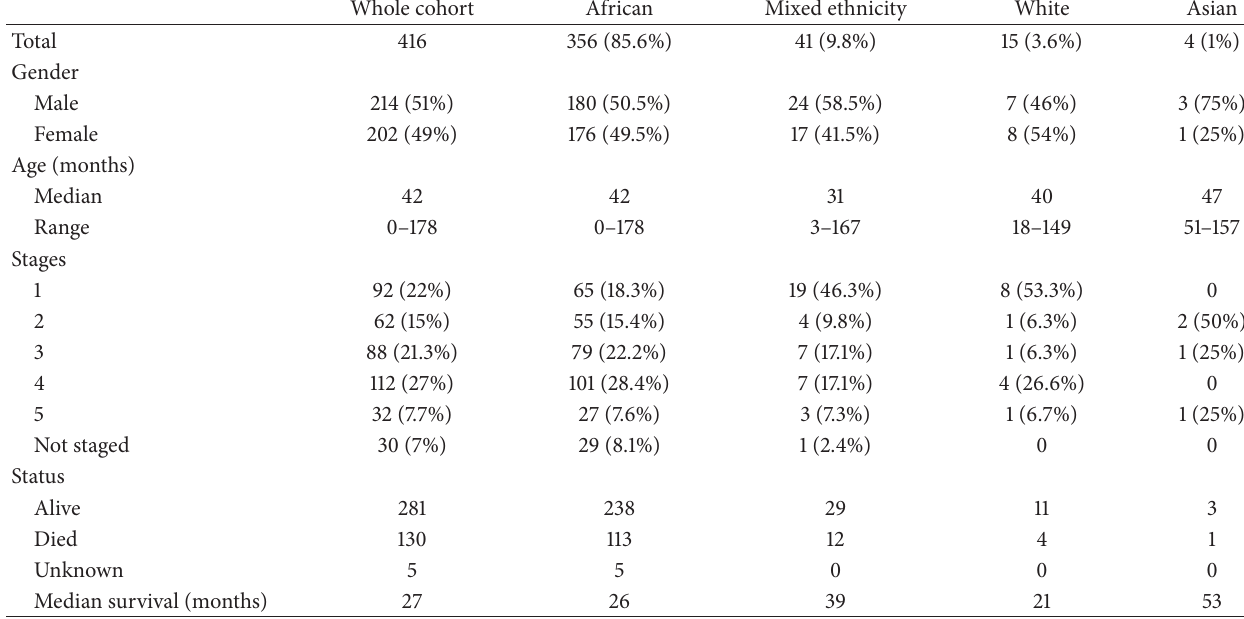
Table 1: Characteristics of the South African